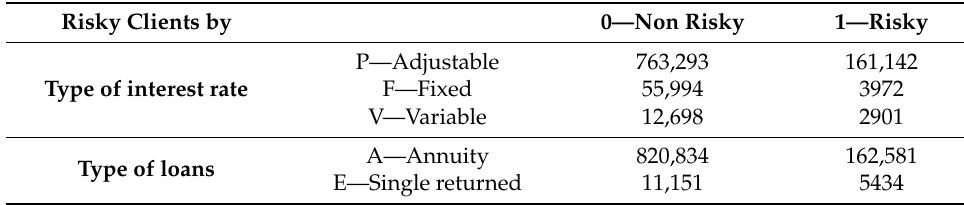
Table 2. Distribution by type of interest rate and type of loans.